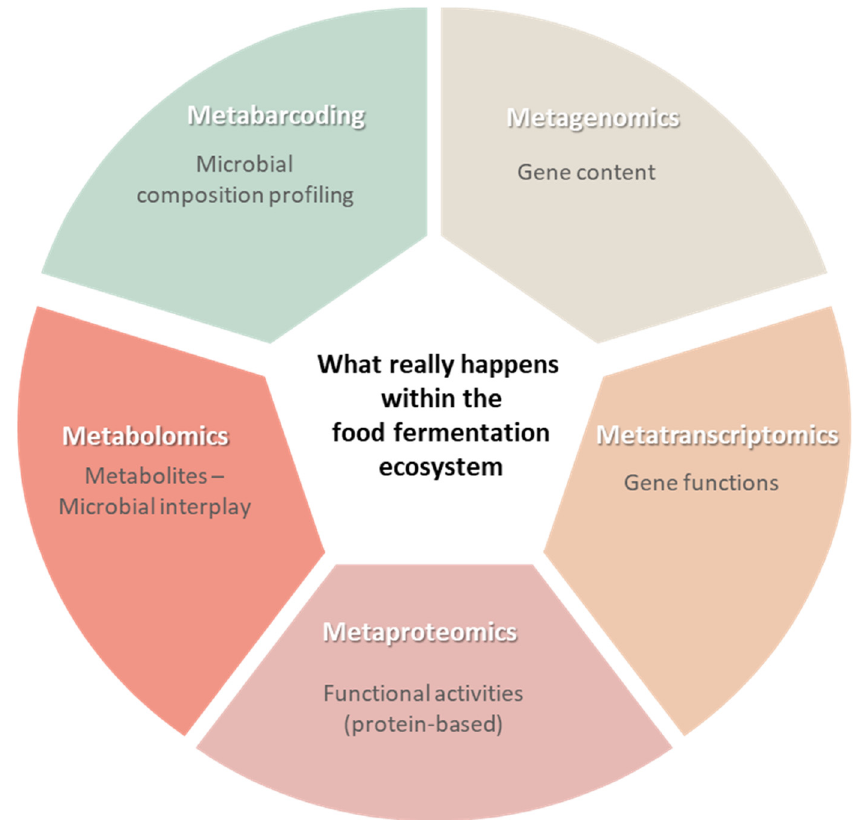
Figure 5. The different tools of the multi-omics analysis and their roles in understanding the food fermentation process, microbiome structure and functional activity profiling. fermentation process, microbiome structure and functional activity